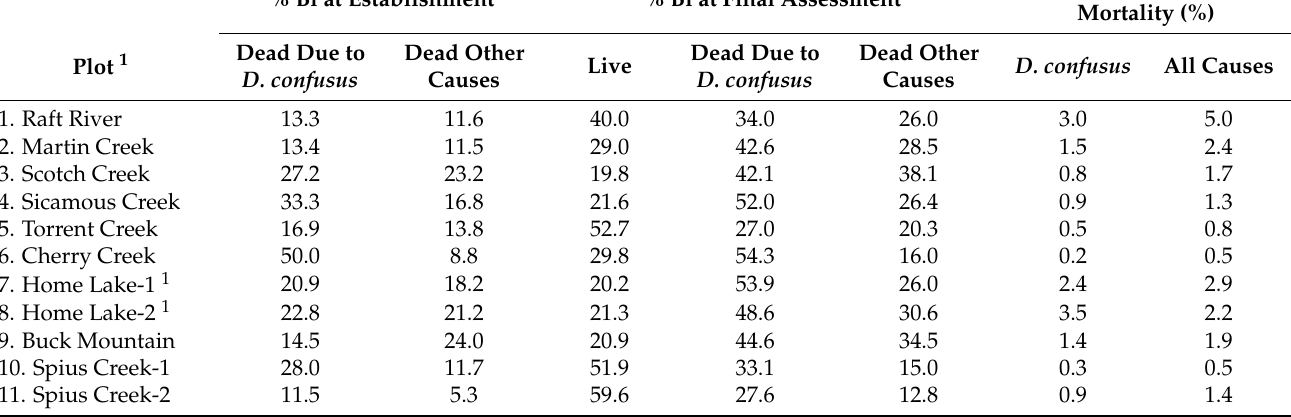
Table 4. The percentage of subalpine fir (Bl) dead due to D. confusus or other causes at plot estab- lishment and final assessment, and the annual rate of mortality from D. confusus alone and from all causes